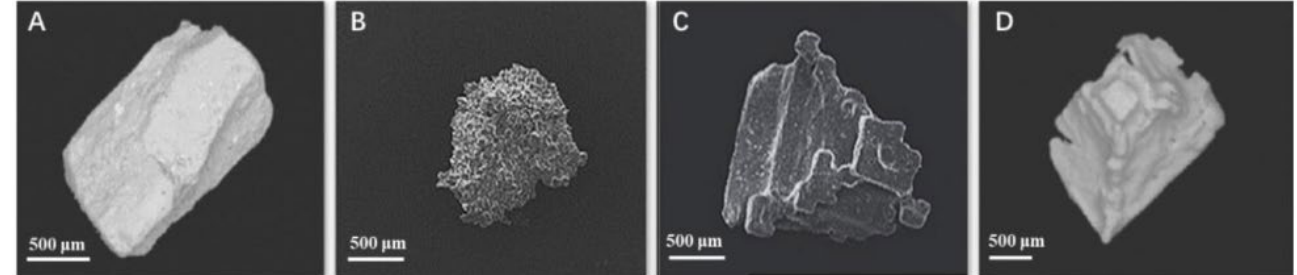
Figure 2. Various morphological forms of salt crystals: ( A ) cubic rock salts; ( B ) aggregate sea salts; ( C ) flaked sea salts; and ( D ) pyramidal sea salts. Reprinted with permission from Refs. [73,74,77]. Copyright 2022 Elsevier Licenses No. 5402170471962, 5402170729257, and 5402170140464.